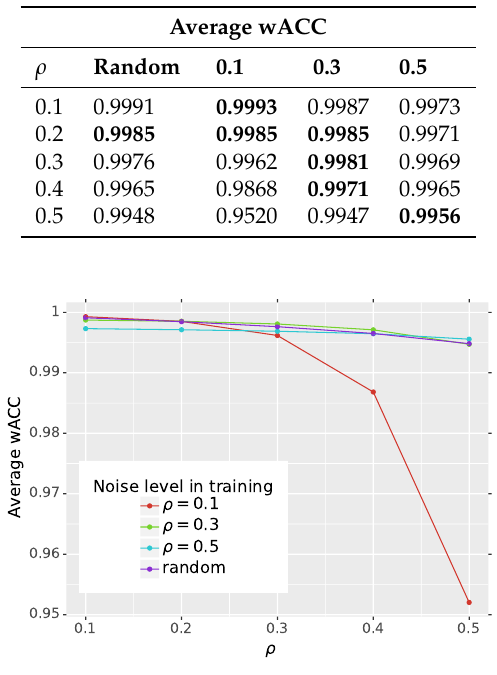
Figure 10. Impact of the noise density used during training on the final network